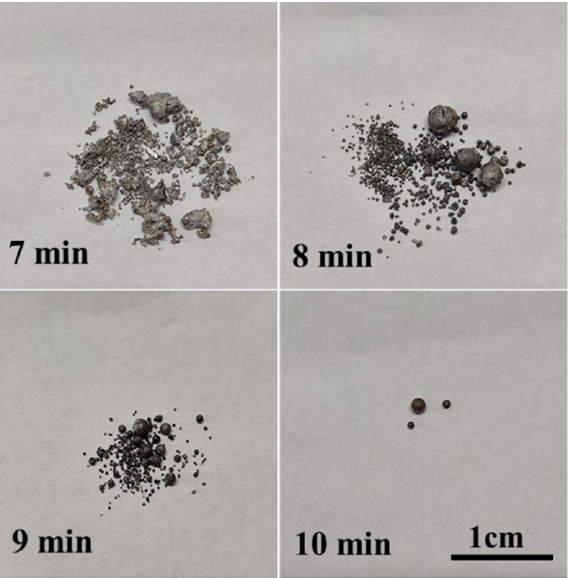
Figure 3. Shape and number of metal droplets dispersed in slag after reacting at 1873 K for various time intervals.